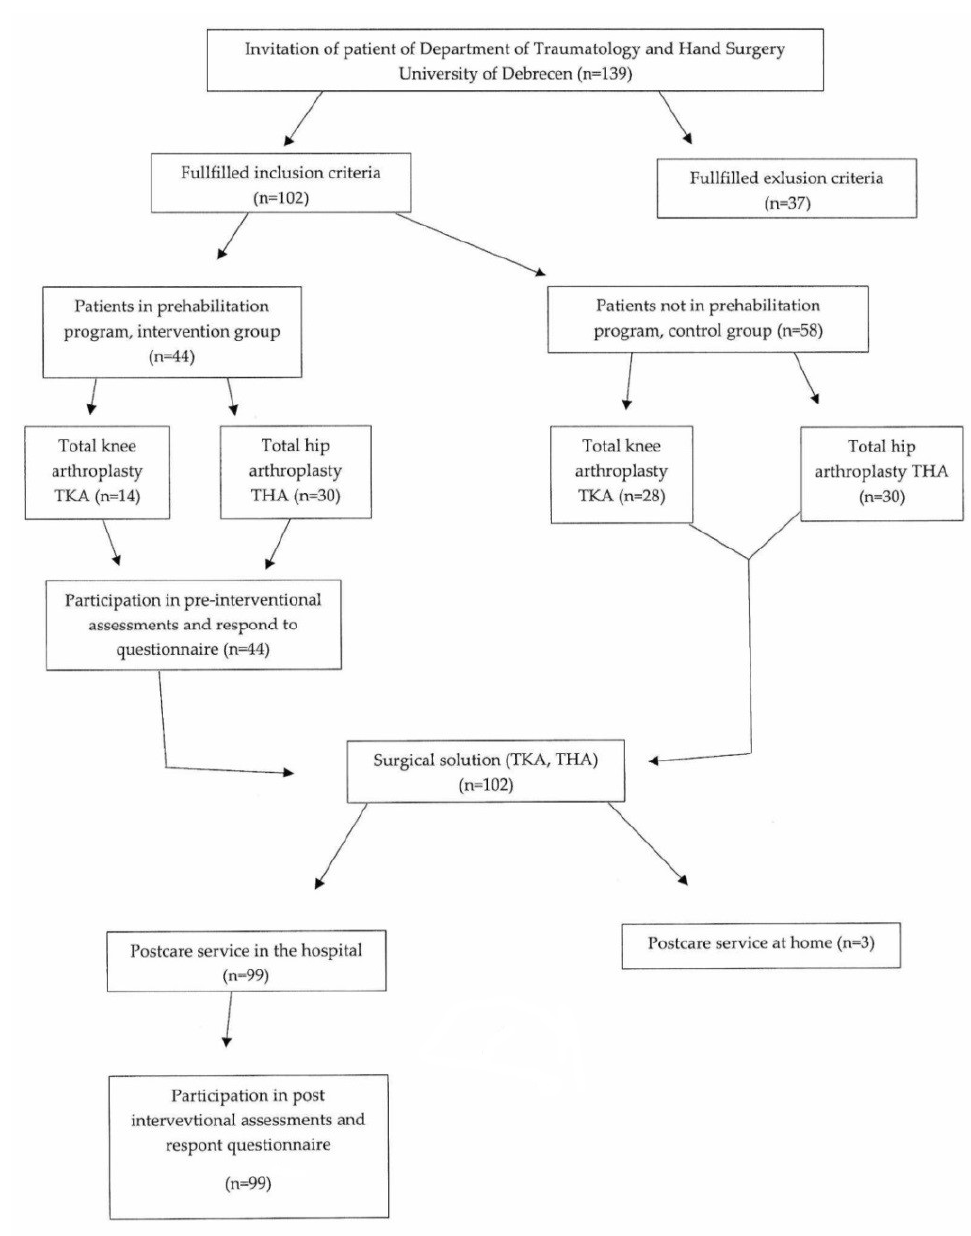
Figure 2. Flow chart of the novel patient